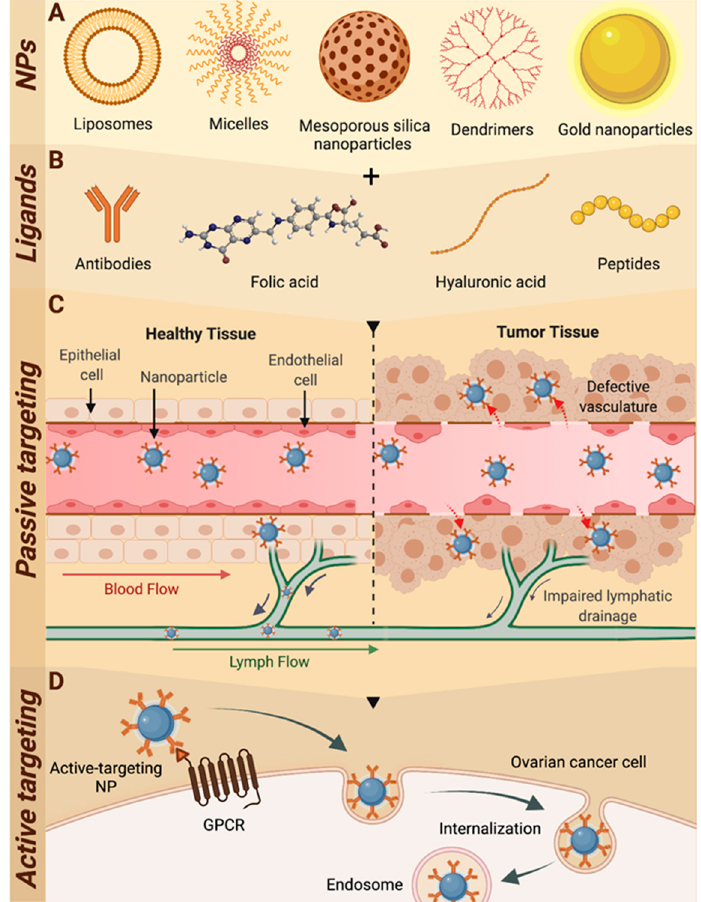
Figure 2. Targeted ovarian cancer NP drug delivery systems: ( A ) diversity of NP drug delivery platform; ( B ) active-targeting ligands of relevance for ovarian cancers (Section 4.1.3); ( C ) passive tumor targeting via the EPR effect; ( D ) internalization of active-targeting NPs driven by receptor activation (e.g., a GPCR or other internalizing receptors). Created with BioRender.com.